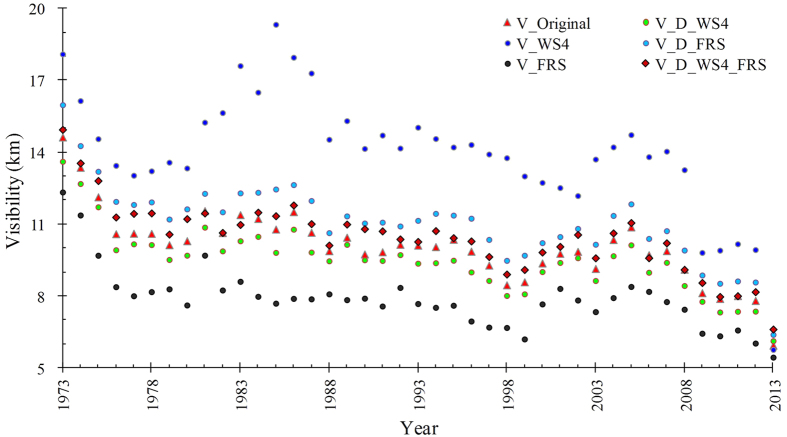
Visibility in Beijing from 1973 to 2012.V_Original is the original annual mean visibility; V_WS4 is annual mean visibility on days with average wind speeds >4 m/s; V_FRS is annual mean visibility on days with fog, rain, or snow; V_D_WS4 is annual mean visibility with wind speed (>4 m/s) days eliminated; V_D_FRS is annual mean visibility, with fog, rain, or snow days eliminated; V_D_WS4_FRS is annual mean visibility, with fog, rain, snow, or wind speed (>4 m/s) days eliminated.